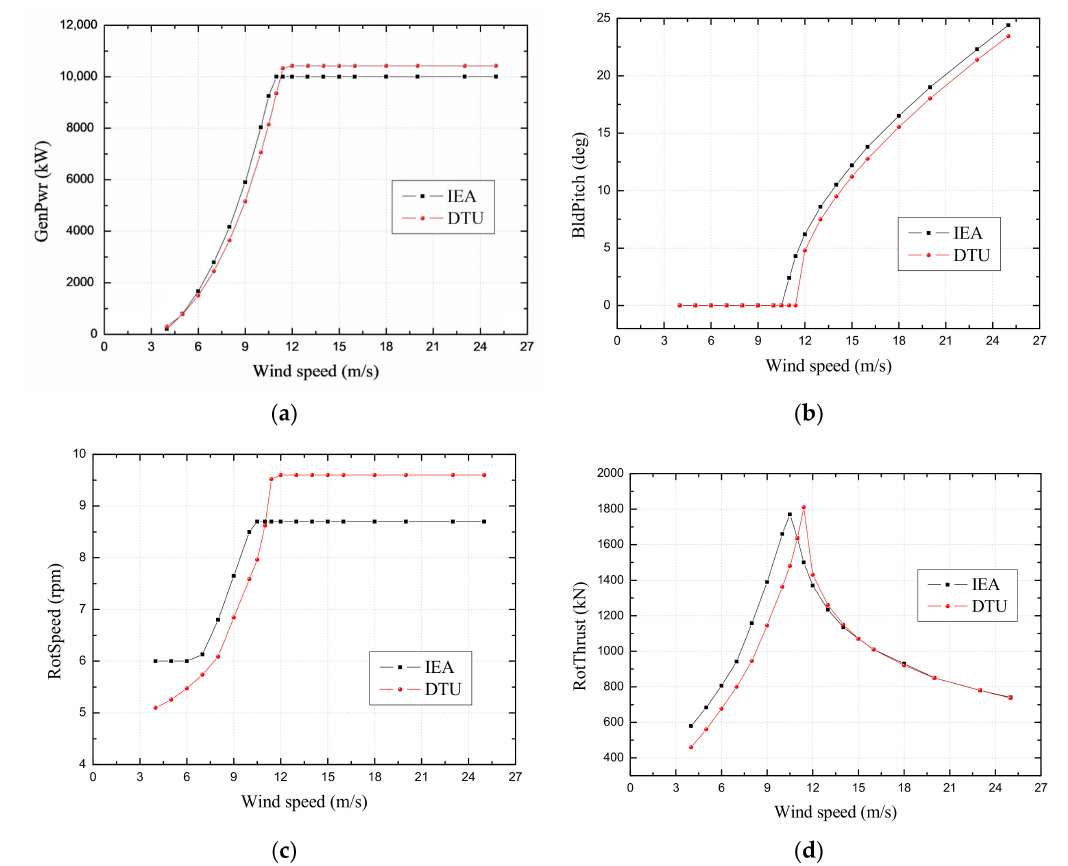
Figure 5. Steady-state performance and operation of the IEA 10-MW offshore wind turbine: ( a ) Gen- erator power vary with the wind speed; ( b ) Bladed pitch angle varies with the wind speed; ( c ) Rotor rotation speed varies with the wind speed; ( d ) Rotor thrust varies with the wind speed.